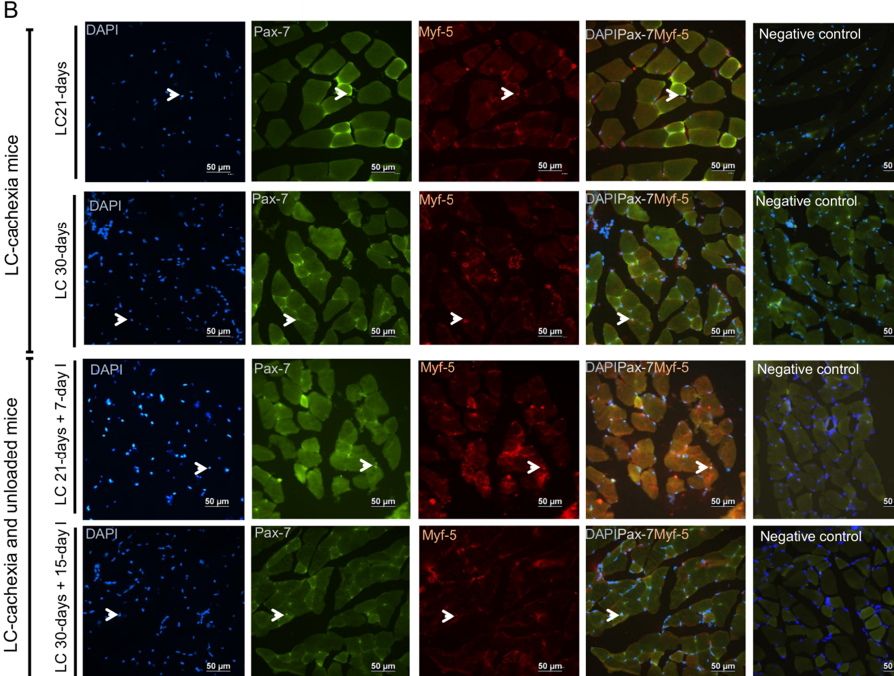
Figure 6. ( A ) Representative images of immunofluorescence staining of DAPI (left panels), Pax-7 (middle-left panels), Myf-5 (middle-right panels) and cells positively stained for both Pax-7 and Myf-5 markers (middle-right panels), and negative controls (right panels) in the gastrocnemius muscle of the NI-control mice and the unloaded mice (7-day I and 15-day I groups of animals). Arrows indicate double-stained nuclei for both Pax-7 and Myf-5 positive cells (activated satellite cells). ( B ) Representative images of immunofluorescence staining of DAPI (left panels), Pax-7 (middle-left panels), Myf-5 (middle-right panels) and cells positively stained for both Pax-7 and Myf-5 markers (middle-right panels), and negative control (right panels) in the gastrocnemius muscle of the LC-cachexia mice (LC 21-days, LC 30-days) and those bearing the two conditions (LC-cachexia and unloading, LC 21-days + 7-day I and LC 30-days + 15-day I groups of mice). Arrows indicate double-stained nuclei for both Pax-7 and Myf-5 positive cells (activated satellite cells). Definition of abbreviations: Pax-7, paired box -7; Myf-5, myogenic factor 5; DAPI, 4′,6-diamino-2-fenilindol; NI, non-immobilized; LC, lung cancer; I, immobilized.